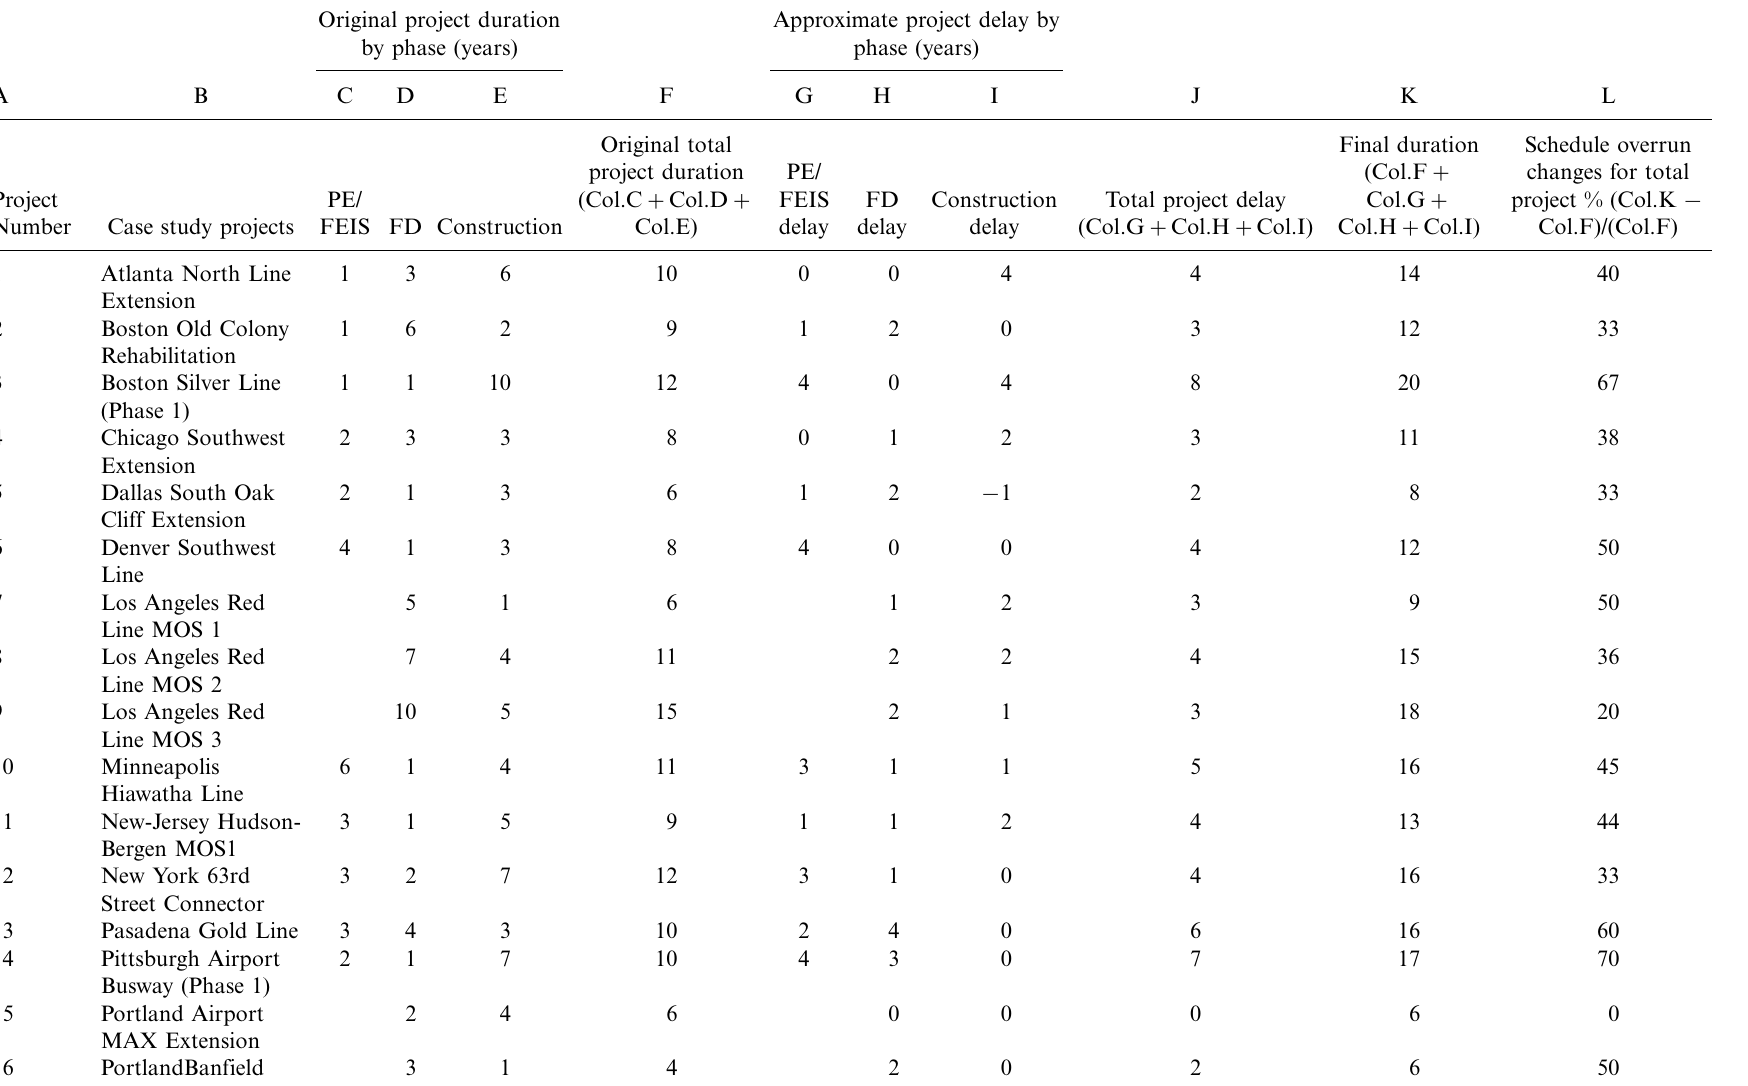
Table 1. Case study project schedule analysis (phases are expressed in